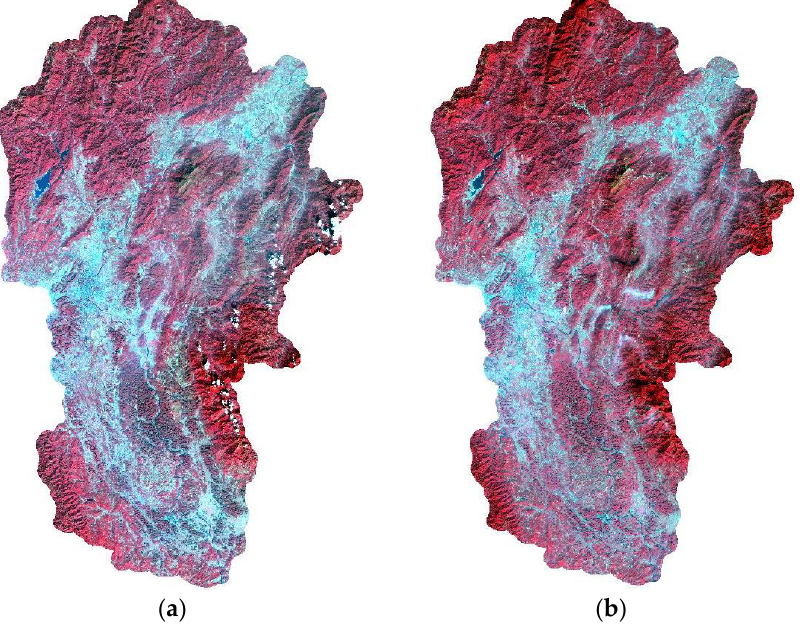
Figure 2. False color composite image of Lijiang River Basin: ( a ) 2009; ( b ) 2013.